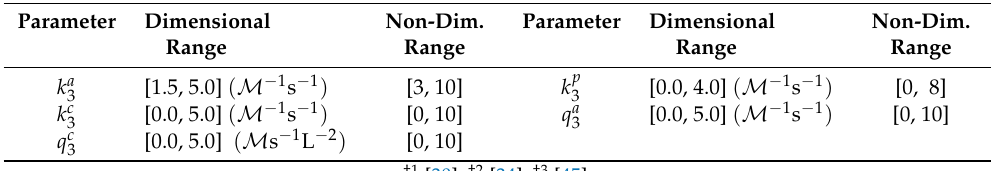
Table A1. Representative parameter set. The parameters L , τ , M are respectively a lengthscale, timescale and a scale of protein number used to non-dimensionalize the model. The dimensional parameters are defined in terms of the protein number scale, so that the non-dimensional model is independent of M . In practice, this means the parameters associated with the non-linear kinetics are such that the non-linear reactions are significant and also in balance with other reactions at typical cellular numbers of proteins. It should be noted that the parameter set below is inherently non-identifiable as, for example, the model depends on the three parameters q a two degrees of freedom q a / q a , q a / q a . For presentational simplicity we have not eliminated such 3 2 3 1 superfluous degrees of freedom from the parameter set, though this would be necessary if parameter inference from experimental data was pursued in future work.